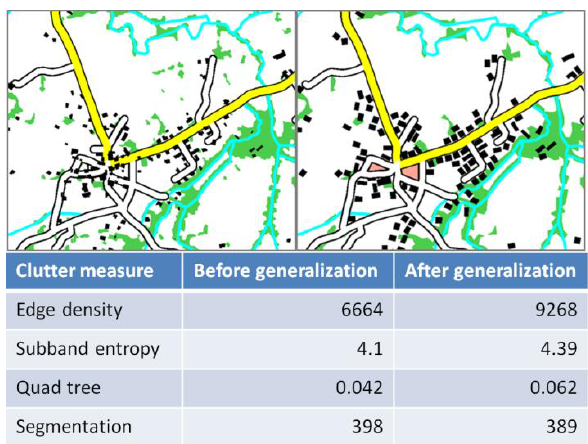
Figure 9. Generalization solves occlusions and overlaps but increases image-based